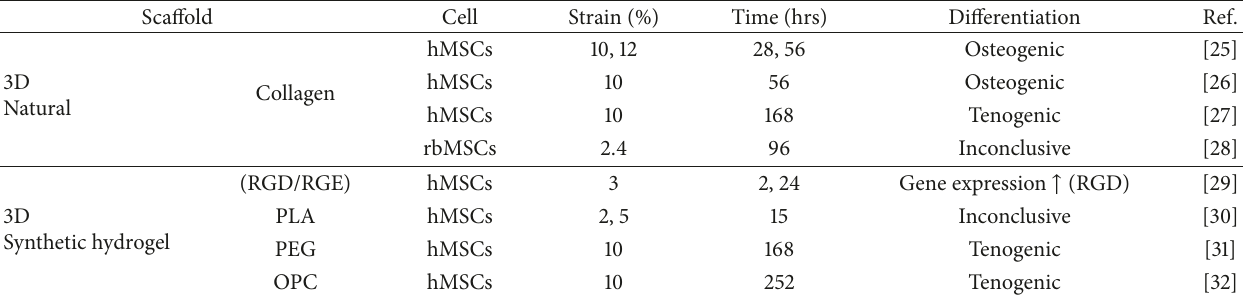
Table 3: Effect of cyclic tensile strain on MSCs within 3D